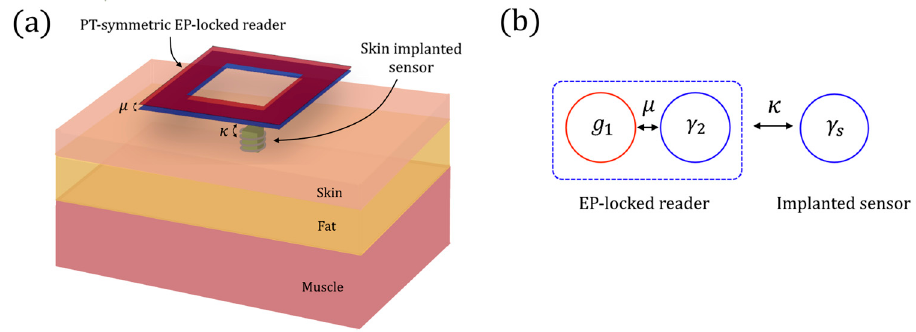
Figure 18. ( a ) Schematic of the EP realized with the implantable LC sensor and the combination of external cavities with gain and loss (proposed in [77]). ( b ) Architecture of an EP-locked reader proposed in [77].